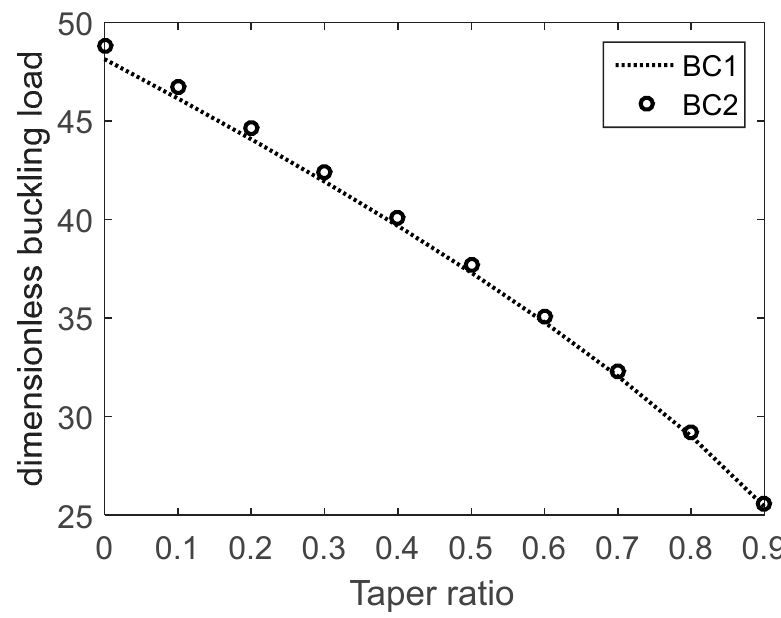
Figure 4. Effects of nonclassical boundary conditions on the dimensionless buckling load of cantilever microbeams corresponding to various taper ratios ( n = 1, l L = h 1 ).